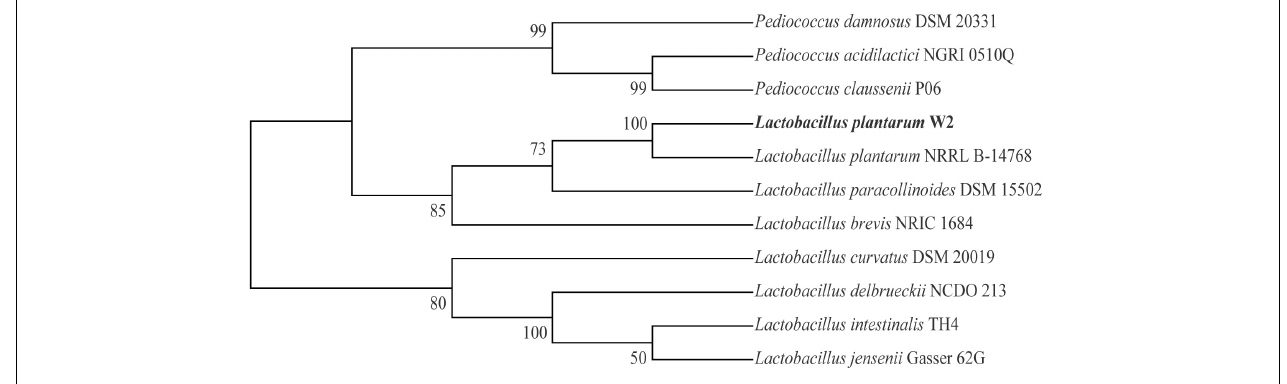
FIGURE 1 | Phylogenetic tree of W2 based on 16S rRNA.